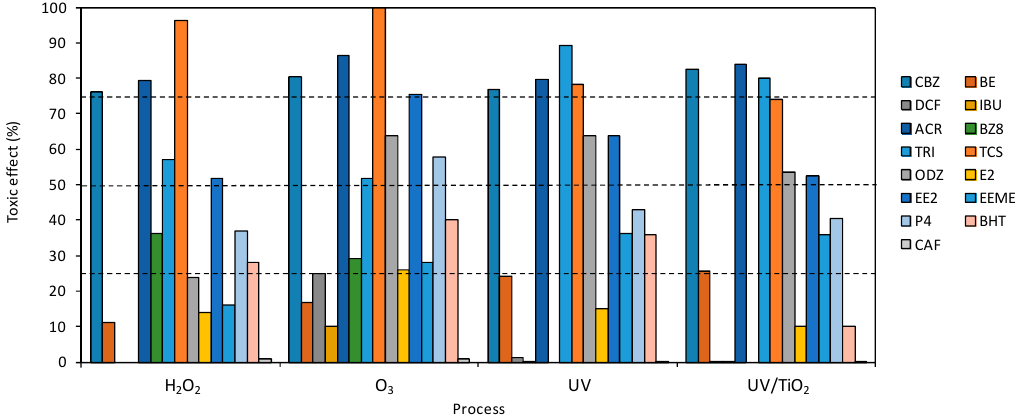
Figure 5. Change in the toxicity of the micropollutant water solution after selected oxidation